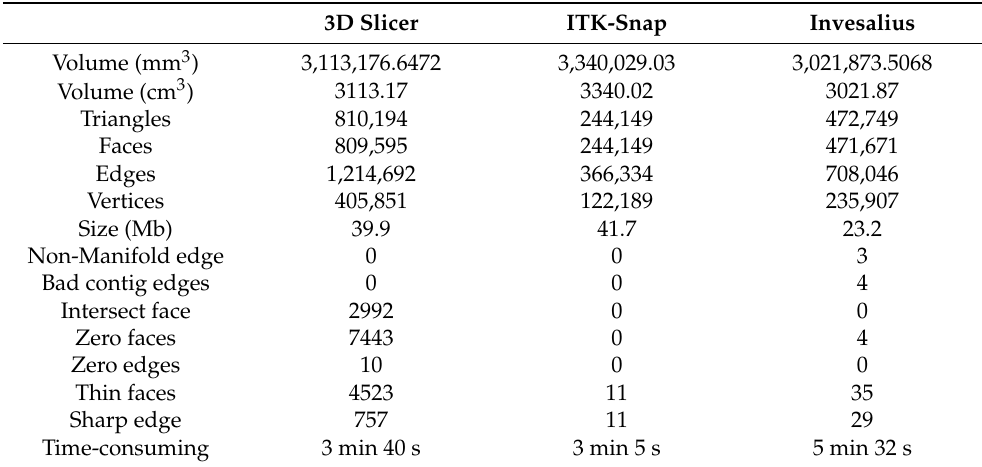
Table 1. Comparison of relevant parameters in the 3D model of the segment. 3D Slicer ITK-Snap